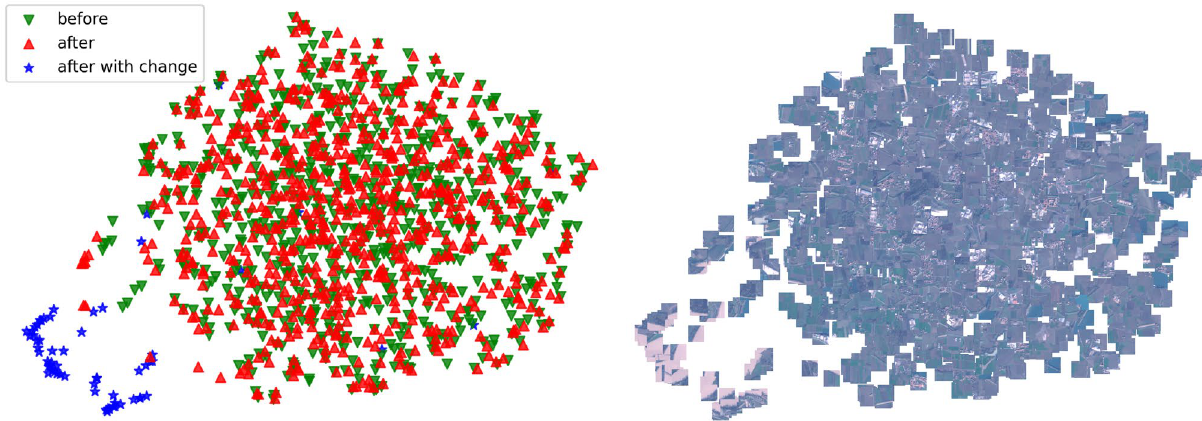
Figure 6. UMAP visualisation of encoded tiles from flooded scene presented on Fig. 4. Tiles from the image before the event are marked as green, while the tiles from after the event are shown in red. Tiles corresponding to the flooded tiles, marked with blue, can be seen clustered together in contrast to the rest of the data from this